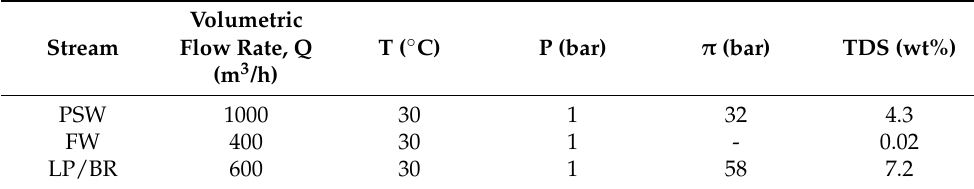
Table 1. Material balances and relevant properties of the incoming and the outcoming liquid streams for the ISWRO desalination process.